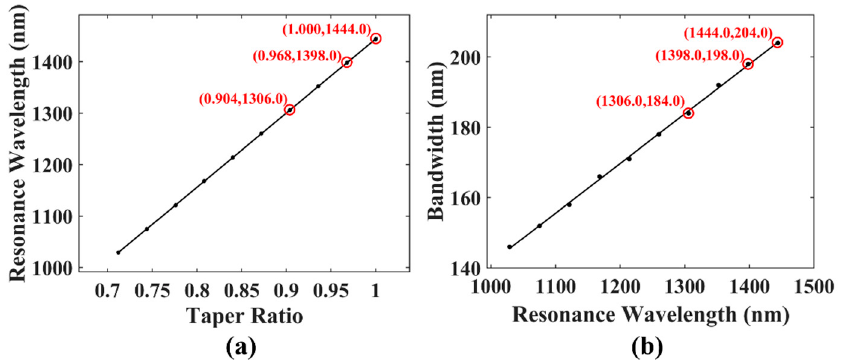
Figure 3. ( a ) The change in the dispersion turning point with the taper ratio. ( b ) The change in the 15 dB bandwidth with the dispersion turning point.